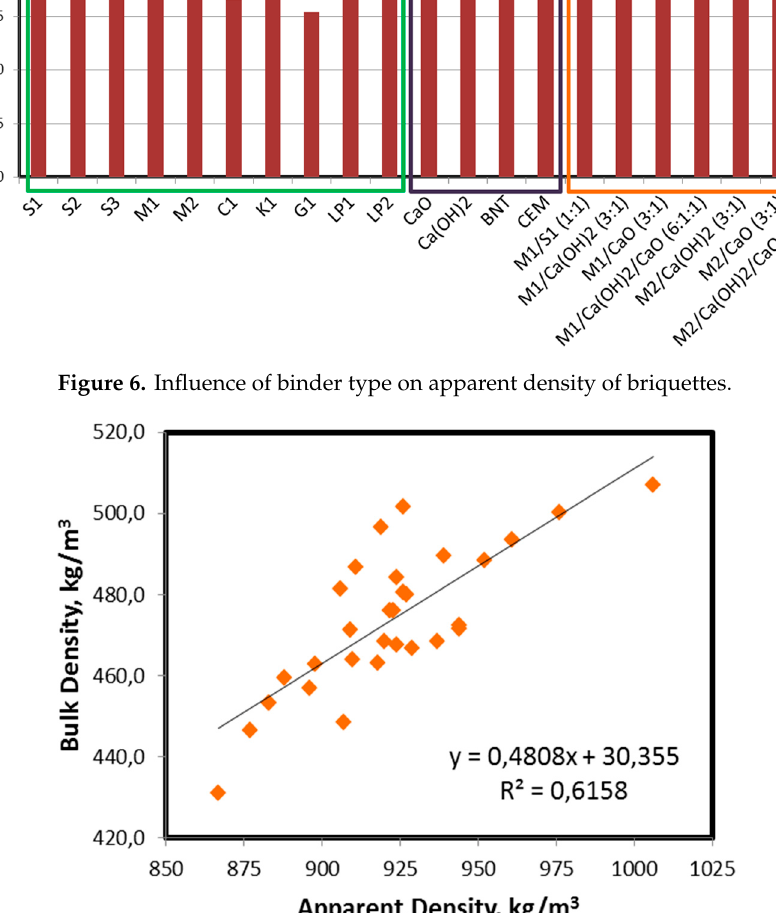
Figure 7. Relation between apparent density and bulk density of briquettes.